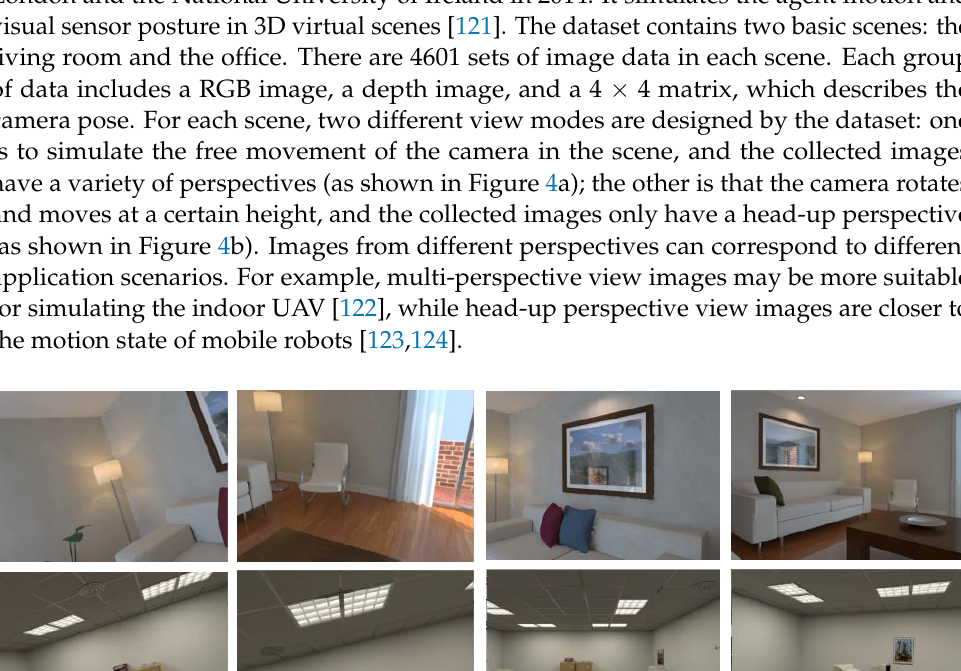
Dataset [121]. Image ( a ) shows the view mode of a variety of camera perspectives. Image ( b ) shows the view mode of a head-up camera